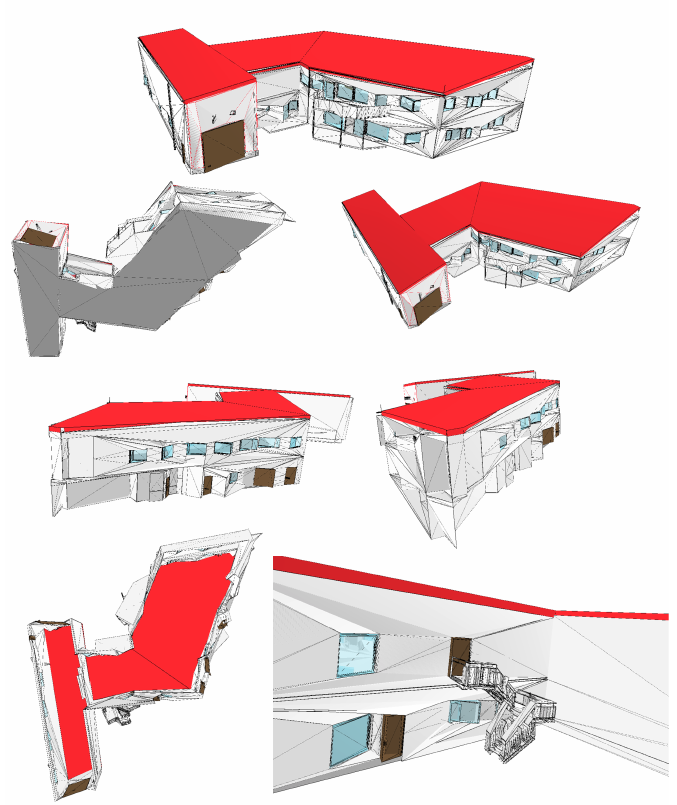
Figure 6. Views of the Myran model converted to CityGML by the test AGIS-FME-RVTr-L1, visualized in azul.